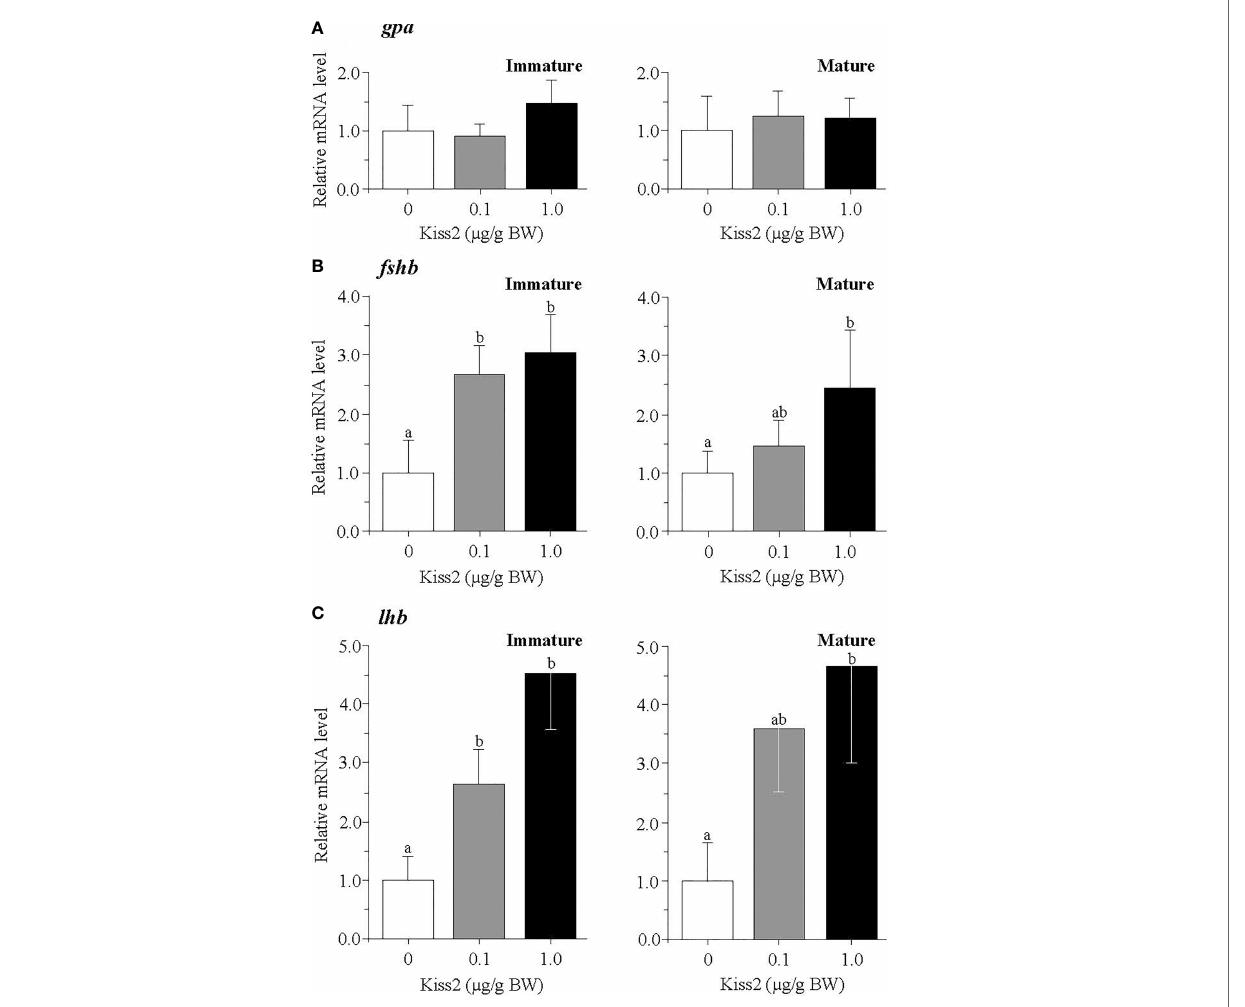
FIGURE 5 | Changes in the relative mRNA levels of gpa (A) , fshb (B) and lhb ( C ) in the pituitary of grass puffer at immature and mature stages after intraperitoneal injection of gpKiss2 for the period of 12hrs. Values are presented as mean ± SEM (n = 6 − 8). Values accompanied by different letters are statistically signi fi cantly different ( p <